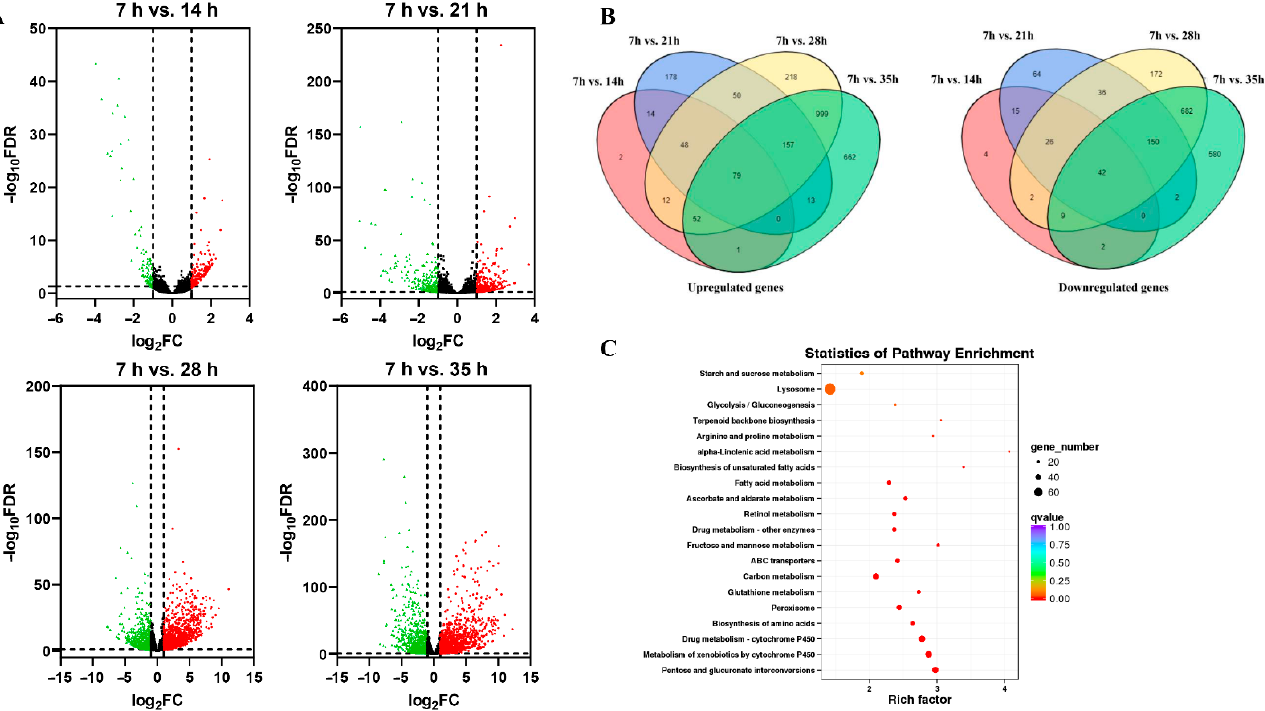
Figure 1. ( A ) Volcano plots of differential expression genes in different developmental time points (14 h vs. 7 h, 21 h vs. 7 h, 28 h vs. 7 h and 35 h vs. 7 h) of deutonymph in T. urticae. ( B ) The venn diagram of the numbers of differential expression genes co-expressed at different time points of deutonymph. ( C ) The statistics of pathway enrichment of all transcript mRNAs in different developmental time points of deutonymph.